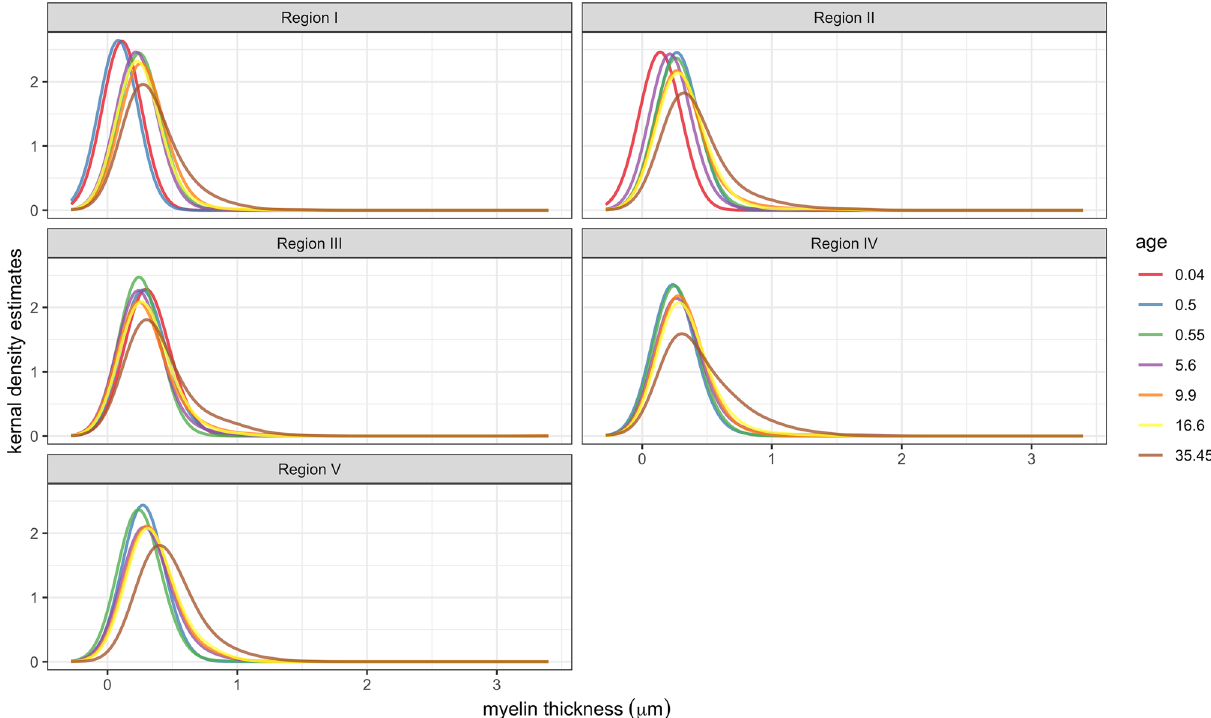
Figure 2. Kernel density estimation plot of myelin thickness measurements in callosal Regions I–V. Subjects are referred to by age in years. Youngest subject (0.04 years) was excluded from Regions IV and V, as no myelinated axons were found in these